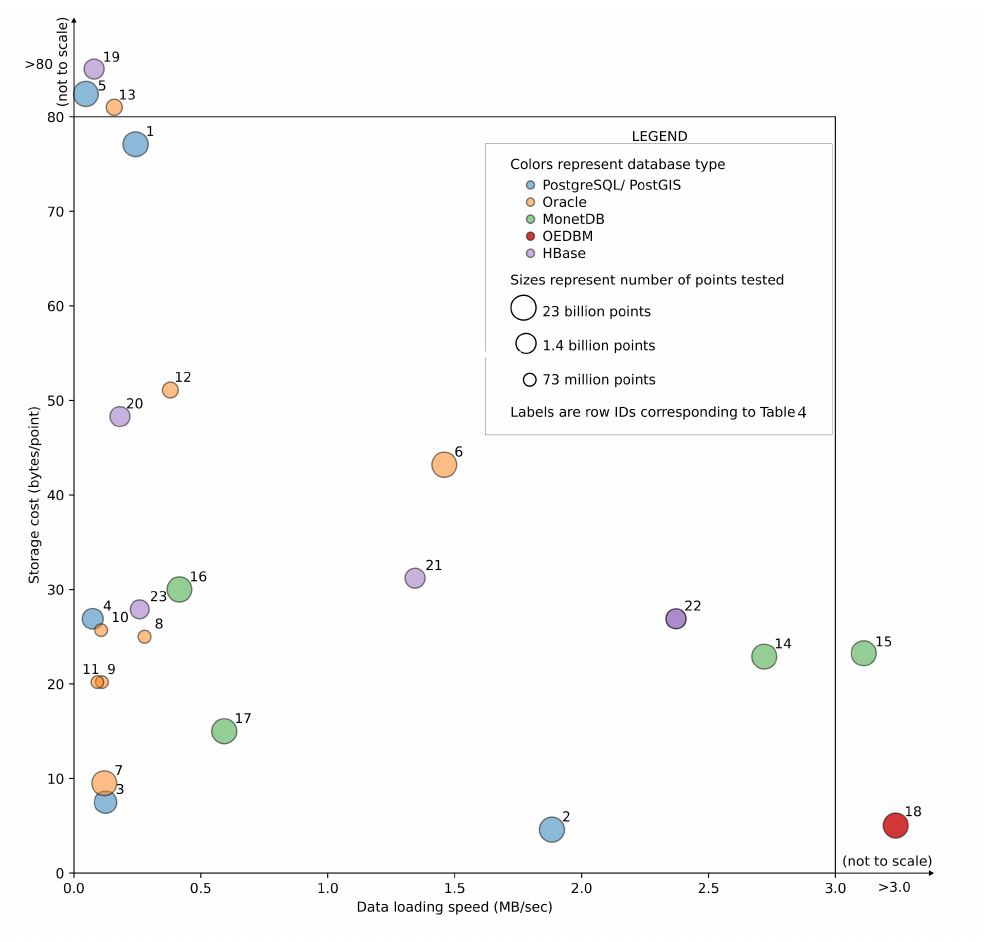
Figure 1. Data loading speeds and storage costs of the existing PCDM